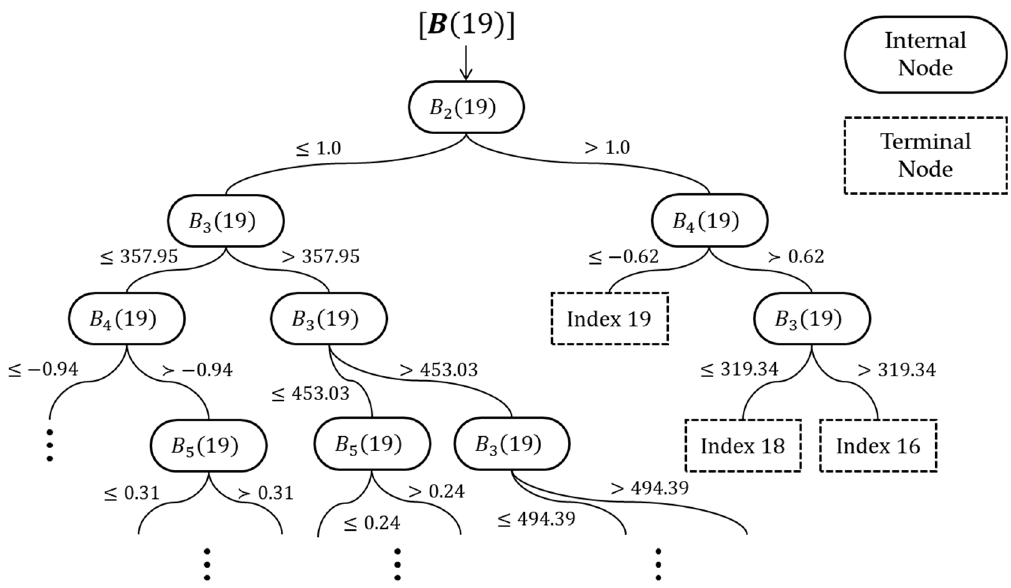
Figure 4. An example of part of a tree classifier. Sensors 2019 , 19 , x FOR PEER REVIEW